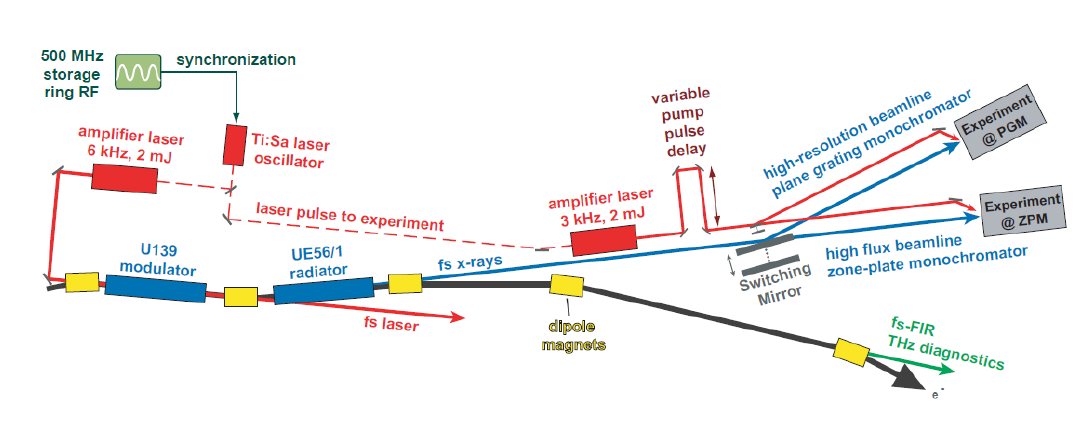
Figure 1: Optical layout of the full optical pump-soft-x-ray probe setup at the FemtoSpeX facility at the BESSY II storage ring (Holldack et al., 2014). The horizontal dimension of the entire setup is ca. 50 m. Synchronized to the 500 MHz master-oscillator driving the rf-cavities of the storage ring, a Ti:Sa oscillator seeds the two regenerative amplifiers that are located in different laser hutches. As a monochromator, either the high resolution Plane Grating Monochromator (PGM) or the high flux Zone Plate Monochromator (ZPM) can be selected by setting a switching mirror to the corresponding position.